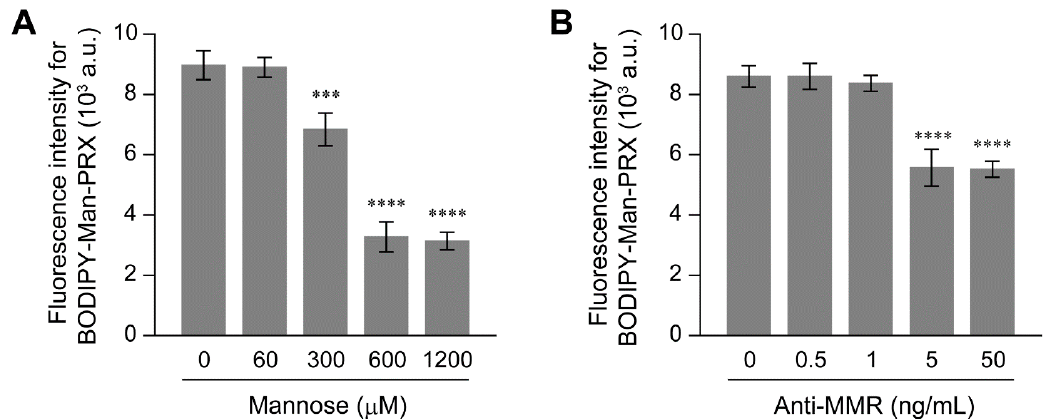
Figure 7. Fluorescence intensity of RAW 264.7 cells pretreated with various concentrations of ( A ) α - D -mannose and ( B ) anti-MMR antibody for 3 h, followed by treatment with BODIPY-Man-PRX for 3 h. The concentration of BODIPY-Man-PRX was 10 µ M, which corresponded to 565 µ M α - D -mannose molecules modified on PRX. Data are expressed as mean ± standard deviation (n = 3, *** p < 0.005 and **** p < 0.001).